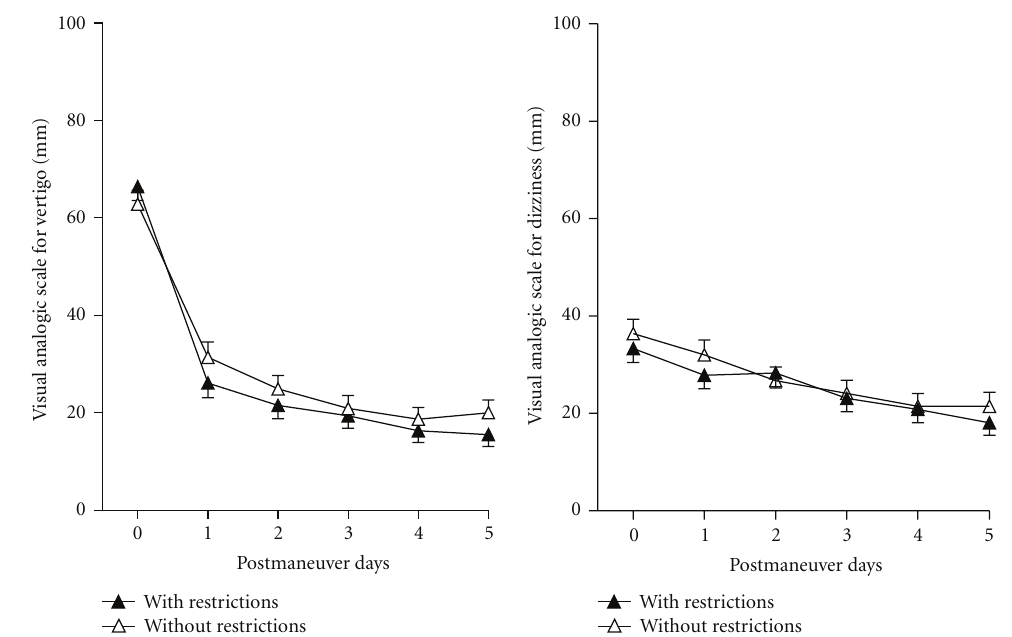
Figure 5: Time course of visual analog scale for vertigo and dizziness as a function of the number of therapeutic maneuvers and the presence or absence of liberatory signs at the 3rd maneuver. VAS was compared between groups with 1, 2, or 3 maneuvers with liberatory signs (vertigo and nystagmus), and 3 maneuvers without liberatory signs independently from the type of maneuver. Scores decreased in both groups with time and no di ff erence could be observed between groups for vertigo (not significant for the e ff ect of number of maneuvers and P < 0 . 0001 for the e ff ect of time, two-way ANOVA). Patients with 2 or 3 maneuvers had higher dizziness scores than those with only one maneuver ( ∗ P < 0 . 01 for the e ff ect of number of maneuvers and P < 0 . 0001 for the e ff ect of time, two-way ANOVA).